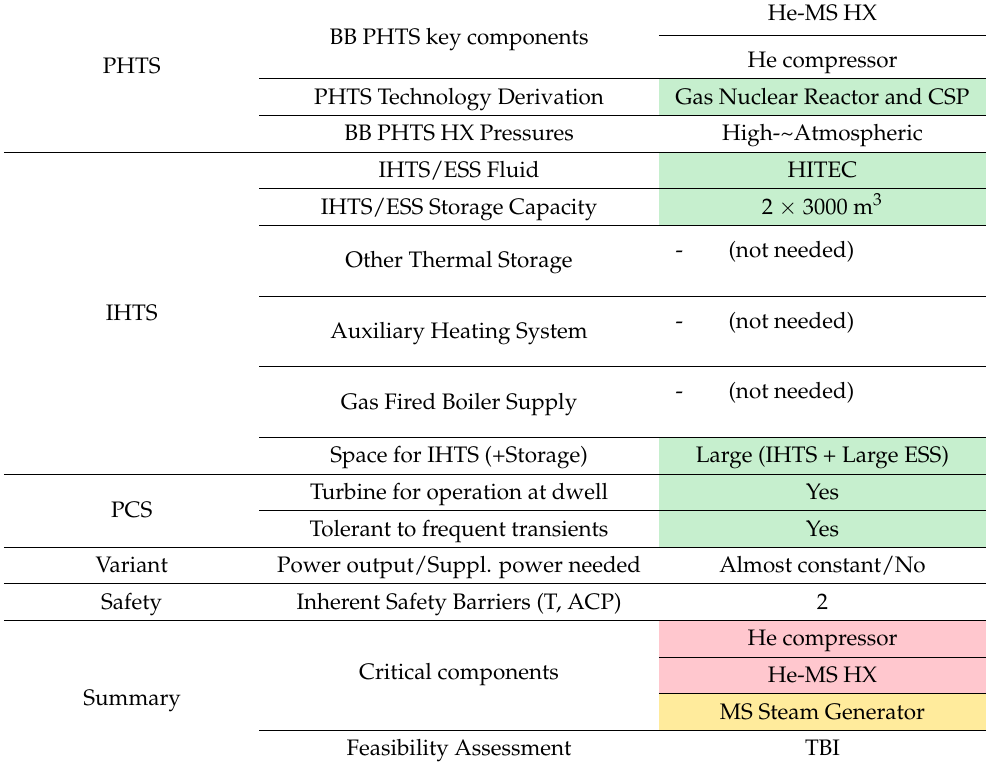
Table 1. Summary of the DEMO HCPB ICD BOP